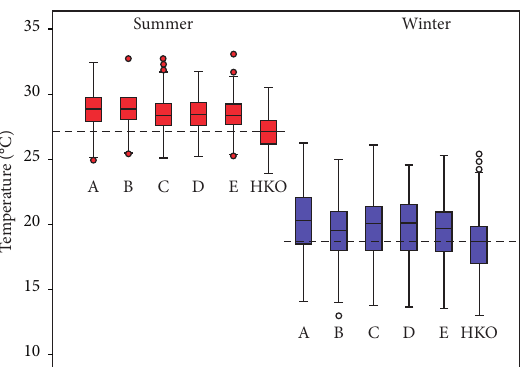
Figure 4: Boxplots of the temperature measurements for points A to E in summer and winter. Summer temperatures are shown in red boxplots, and winter temperatures in blue boxplots. Boxplots of the official urban HKO for both seasons are referenced (black horizontal lines). The small circles above and below the boxplots represented the outliers of the